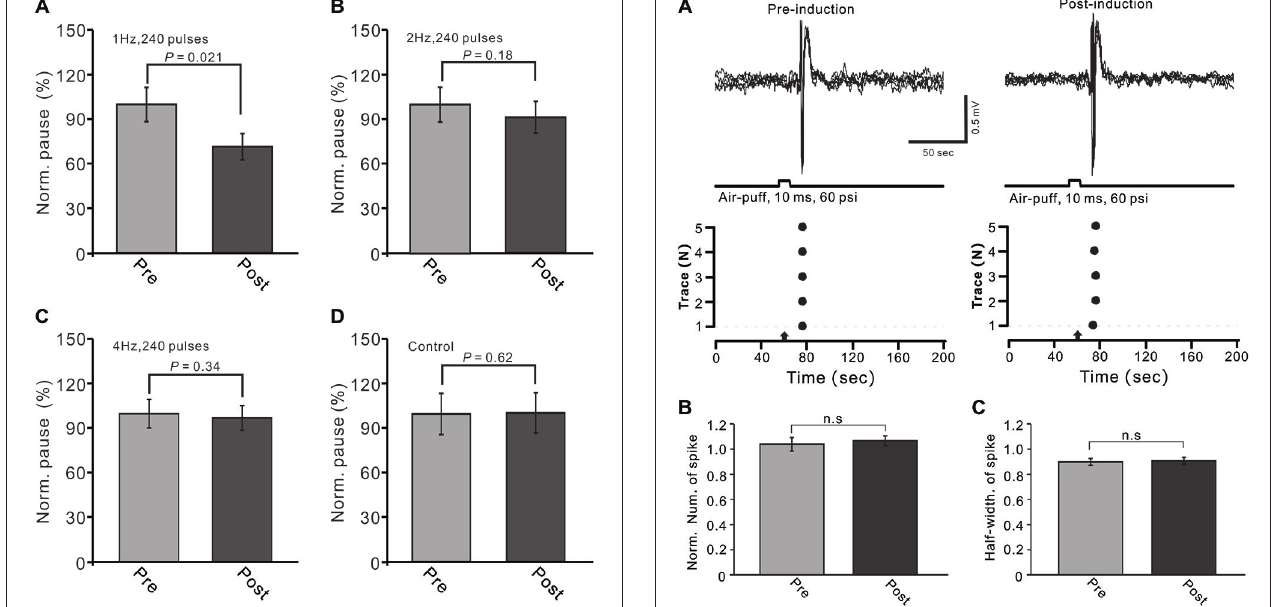
FIGURE 5 | Facial stimulation had a lesser effect on cerebellar MLI activity . (A) Upper, superposition of five representative recording epochs showing air-puff stimulation (10 ms, 60 psi)-evoked spike firing in an MLI before (left) and after (post) delivery of 1 Hz (240 pulses) stimulation. The lower panel shows the master plot of spike events derived from traces of the upper panel. (B) Summary of normalized number of spike events before (Pre, red) and after delivery of 1 Hz stimulation (Post; n = 6). (C) Pooled data showing the normalized half-width of the sensory-evoked spike events before (Pre) and after delivering 1 Hz stimulation (Post; n = 6). Note that air-puff stimulation at 1 Hz did not induce a significant change in the properties of the sensory-evoked spike events on